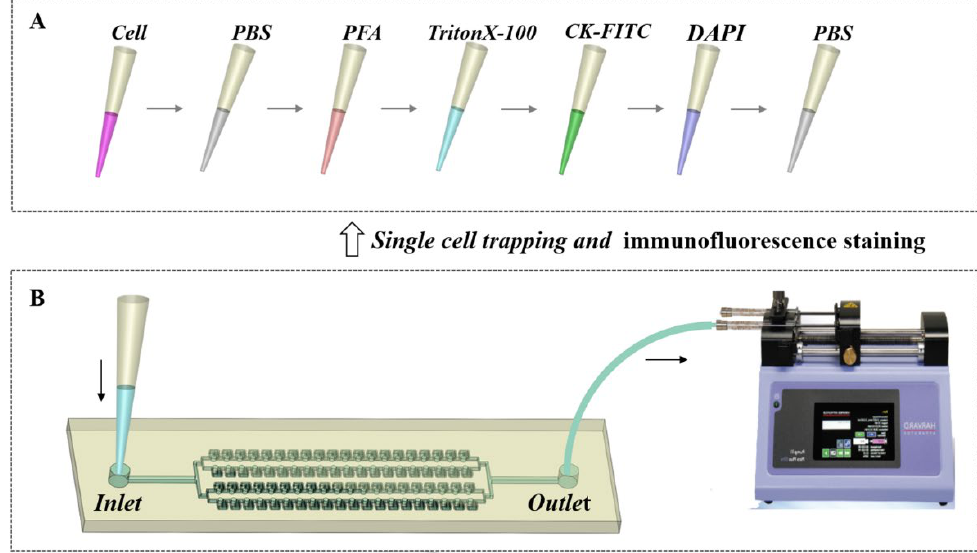
Figure 2. The procedure of single-cell trapping and immunofluorescence staining. ( A ) Cell suspension and immunofluorescence staining reagents were delivered into the chip sequentially. ( B ) The pulling force was applied at the outlet with a syringe pump to deliver the solution from the pipette tip into the chip.